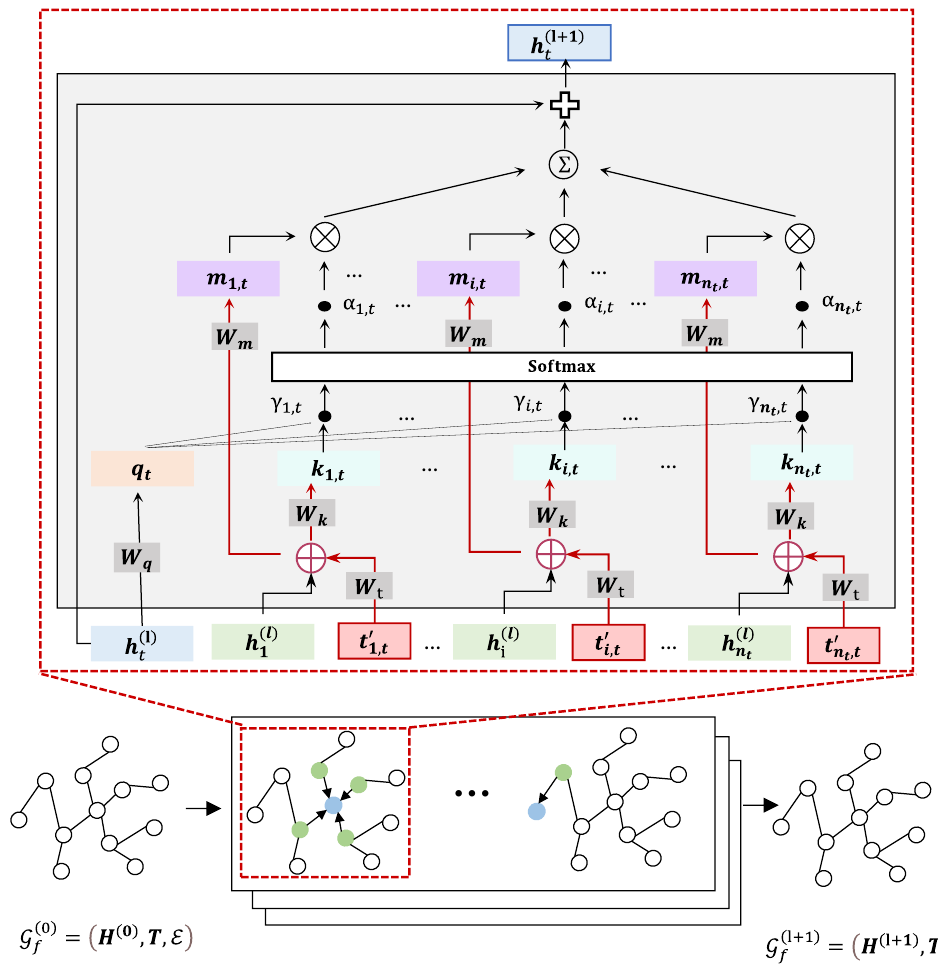
Figure 6. Diagram of the type-aware graph attention module (TAGAT).